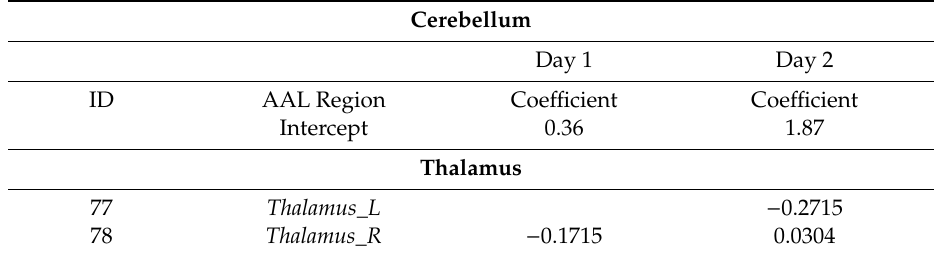
Table 3. Combinations of thalamus and cerebellum AAL regions predicting GWI versus control status. Logistic regression model coefficients and voxels per AAL region were shown for models that predicted GWI versus control status prior to (Day 1) and after (Day 2) exercise.